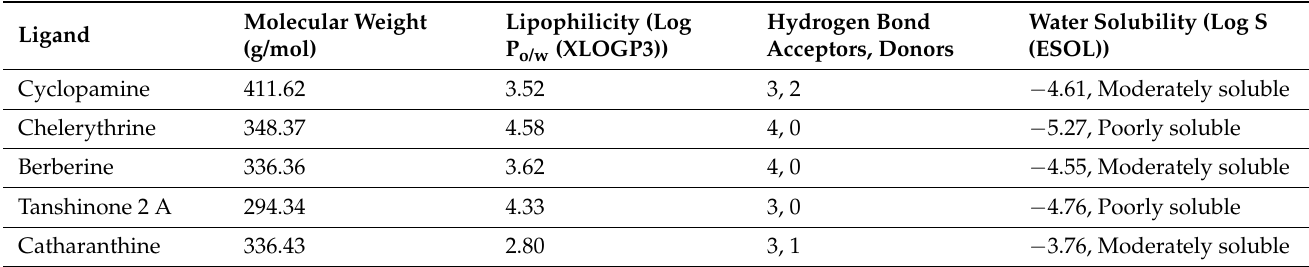
Table 3. Drug likeness and ADME results for Top ligands.